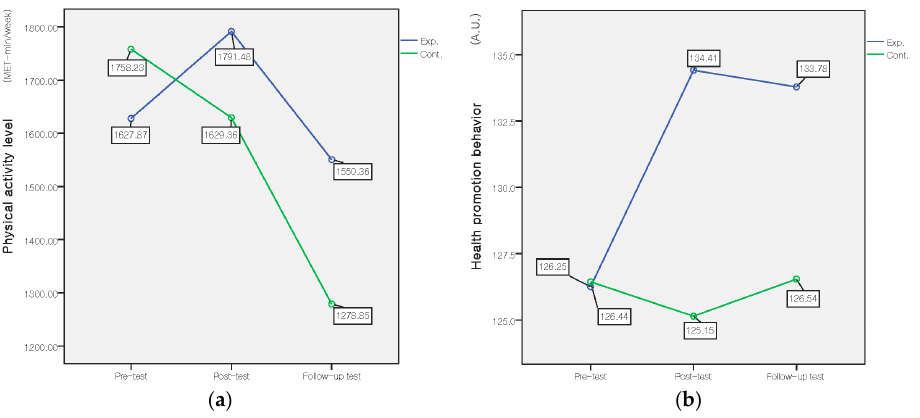
Figure 3. Comparison of the mean physical activity level ( A ) and health promotion behavior score ( B ) between the experimental and control groups at pre-, post-, and follow-up test. Exp.: experimental group; Cont.: control group; A.U.: arbitrary